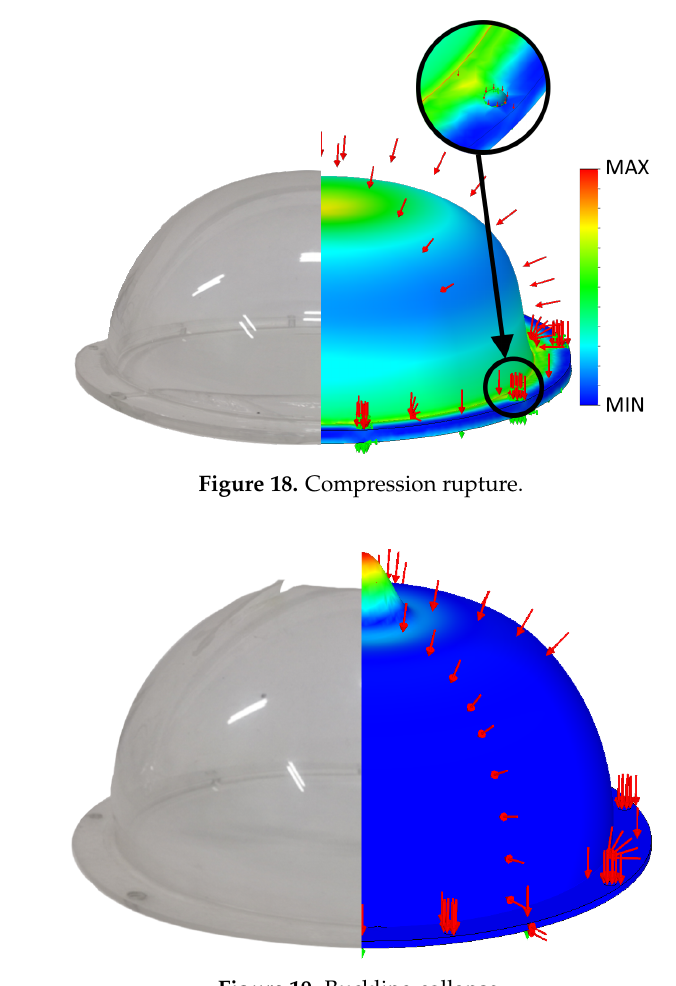
Figure 19. Buckling collapse.